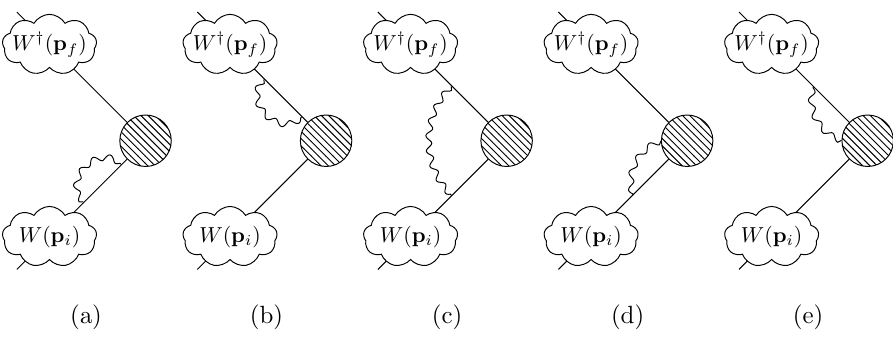
Figure 4. Graviton exchanges that do not involve dressings. The soft graviton loops exponentiate and factor out